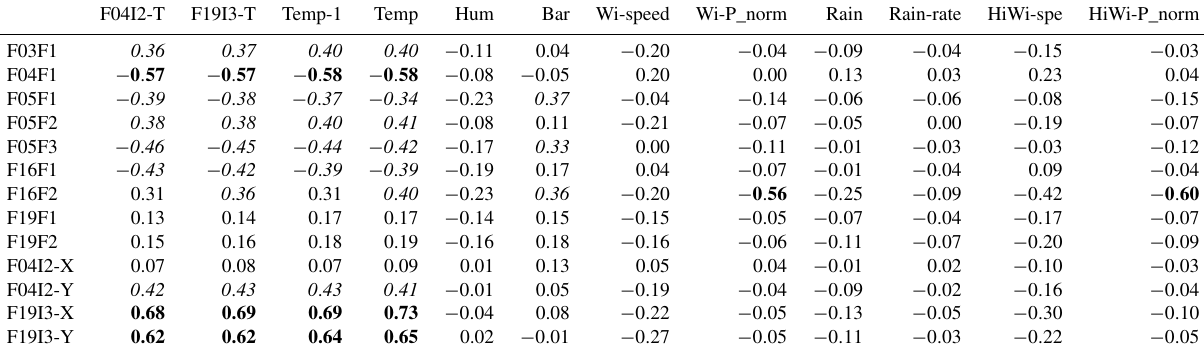
Table 11. Correlation matrix of tuff deformation and meteorological data; the correlations greater than | 0 . 5 | or | 0 . 33 | are in bold or italics, respectively.